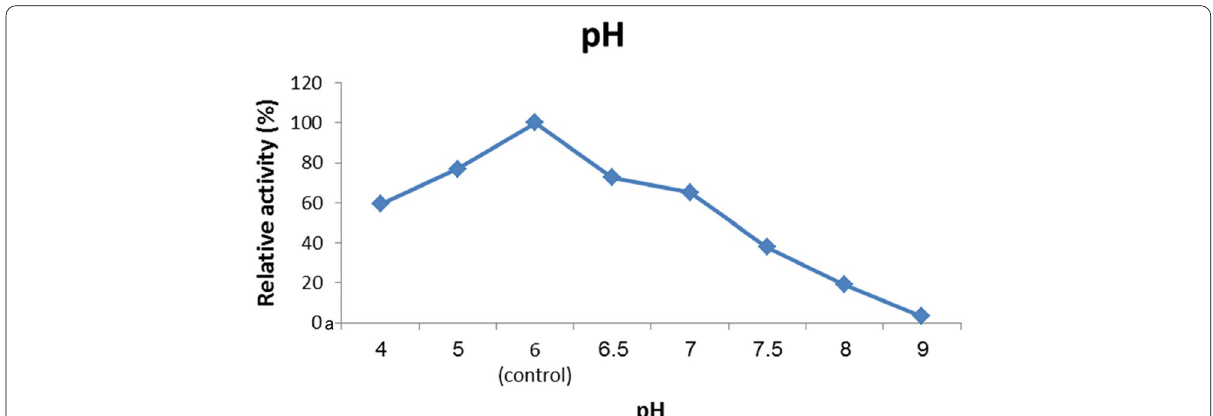
Fig. 6 The effect of the reaction mixture’s pH on A. terreus strain RGS activity. Xylanase Eg‑NRC. With 1% (w/v) xylan, the reaction was carried out at 50 °C